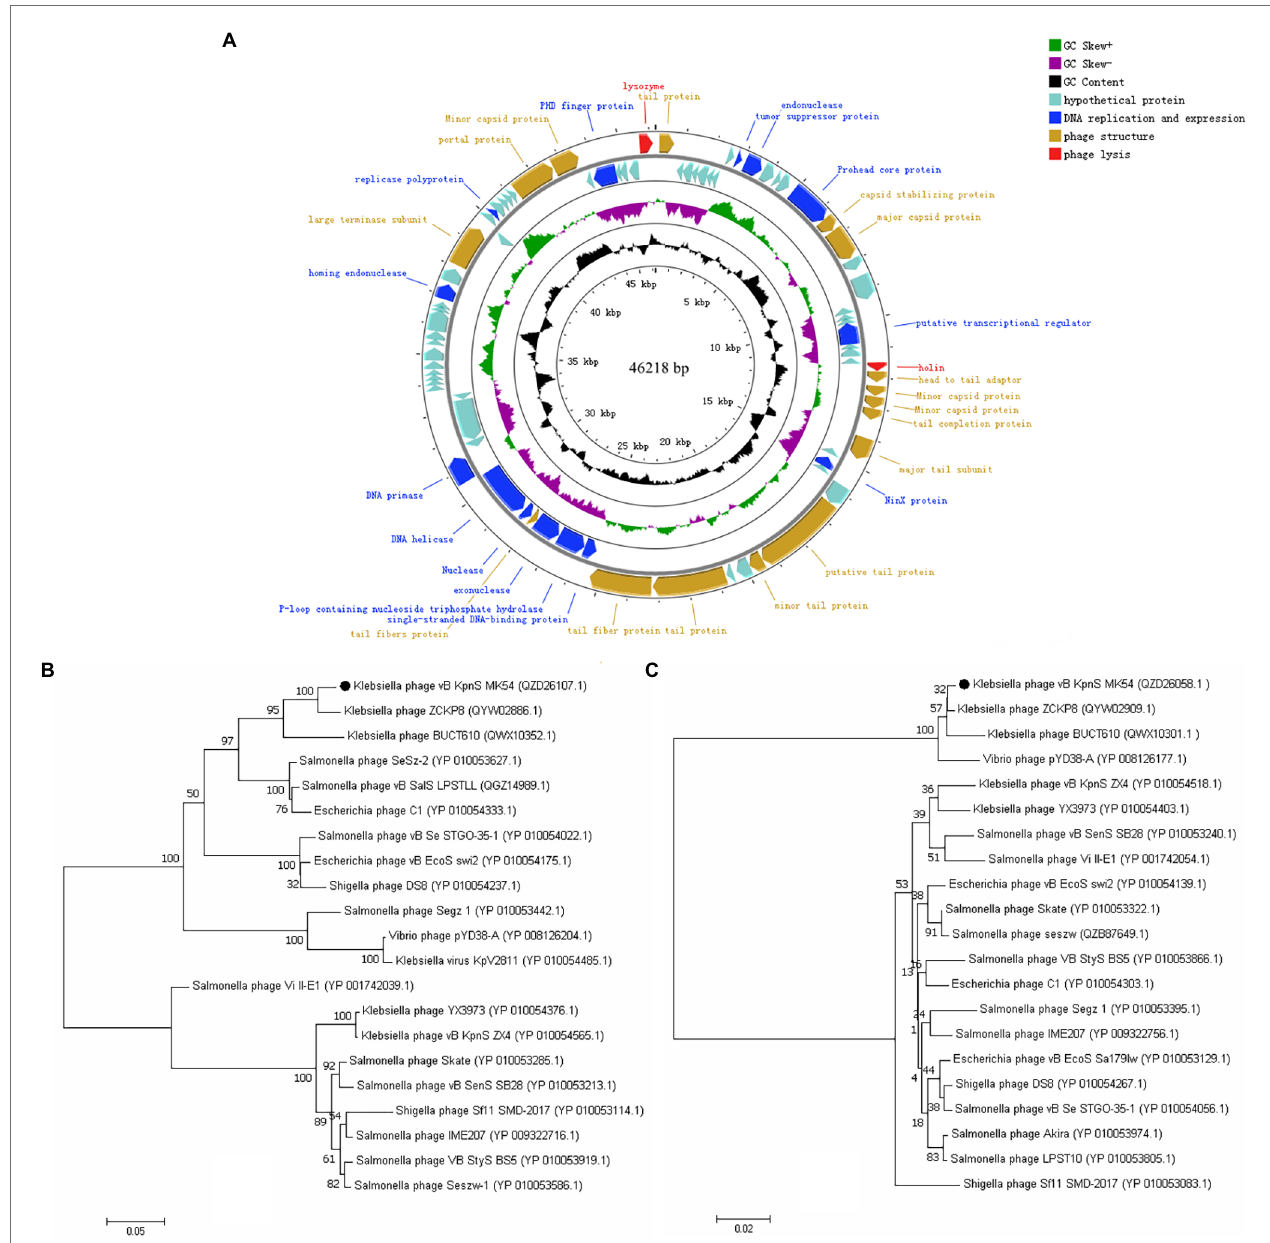
FIGURE 2 | Complete genome and phylogenetics trees of phage vB_KpnS_MK54. (A) The outermost circle is the 80 CDS coded by vB_KpnS_MK54. The arrows represent the direction of gene transcription, and the colours represent genes with different functions: lysis-related genes (red), DNA replication and expression genes (blue), functional structural genes (brown) and hypothetical protein genes (cyan). Phylogenetics trees were formed based on the (B) terminase large subunit and (C) major capsid protein of the